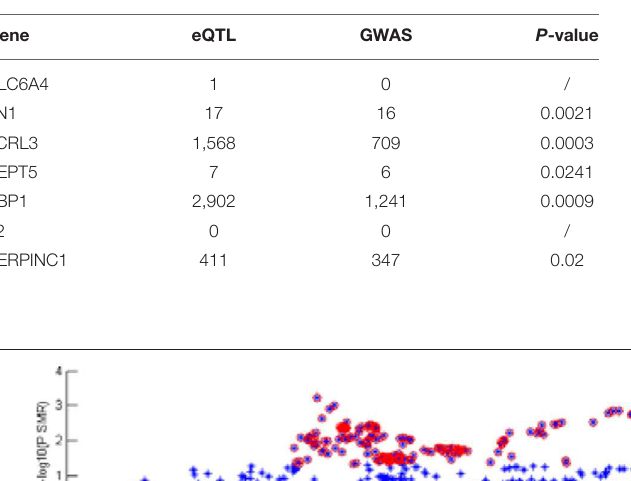
Frontiers in Cell and Developmental Biology |